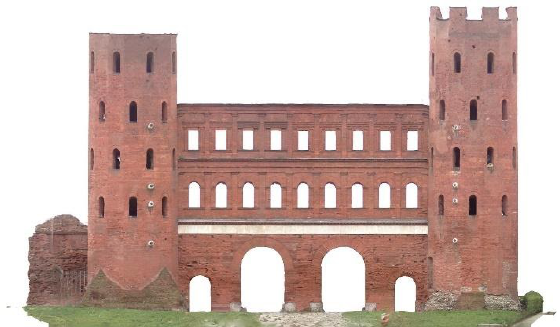
Figure 6 . Orthomosaic of the north elevation of the Porta Palatina produced starting from the texturized model